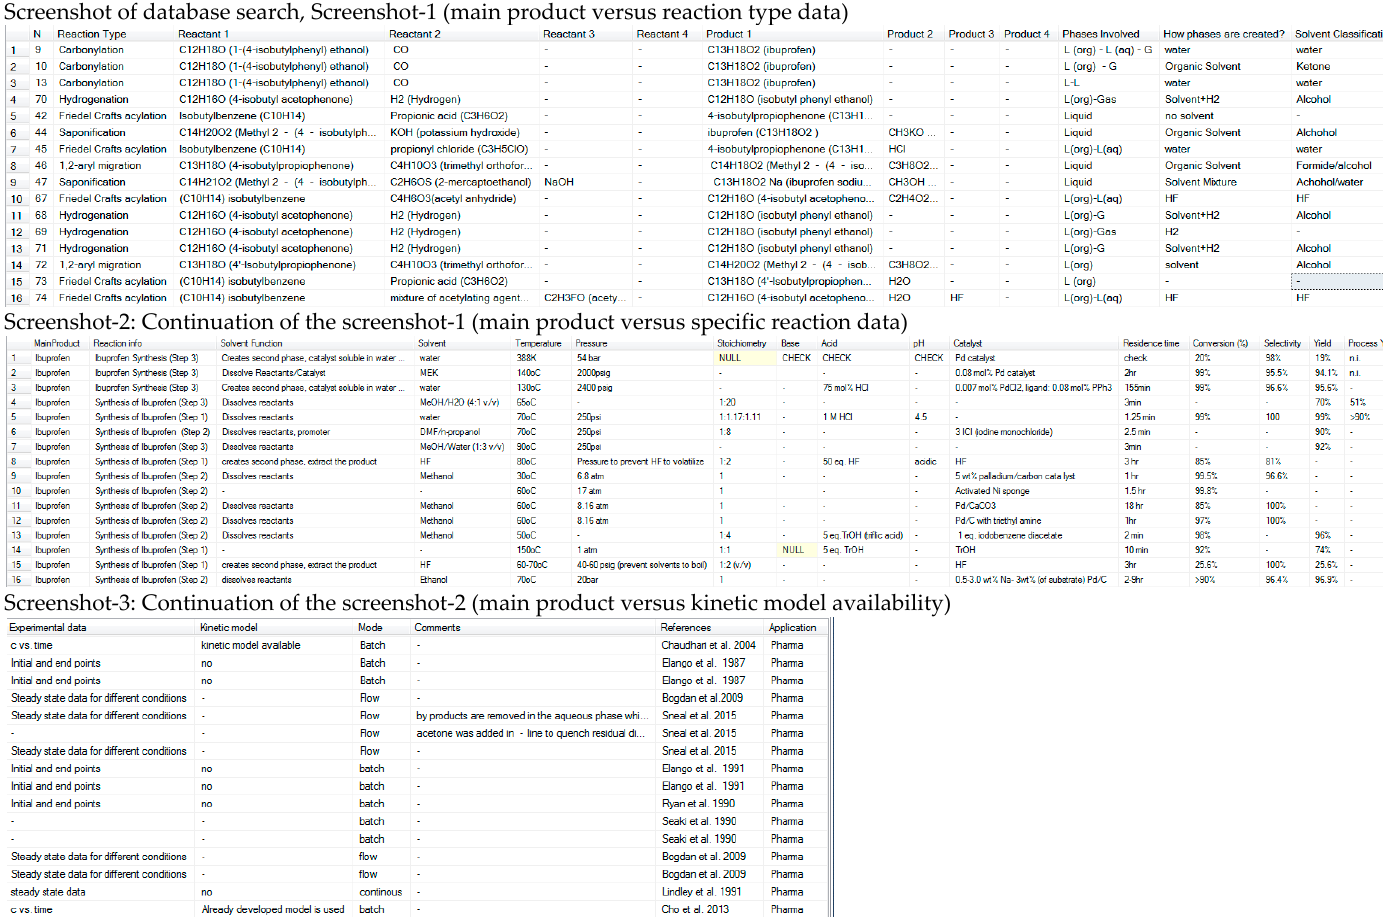
Figure 4. Reaction database search results for “Main Product = Ibuprofen”.